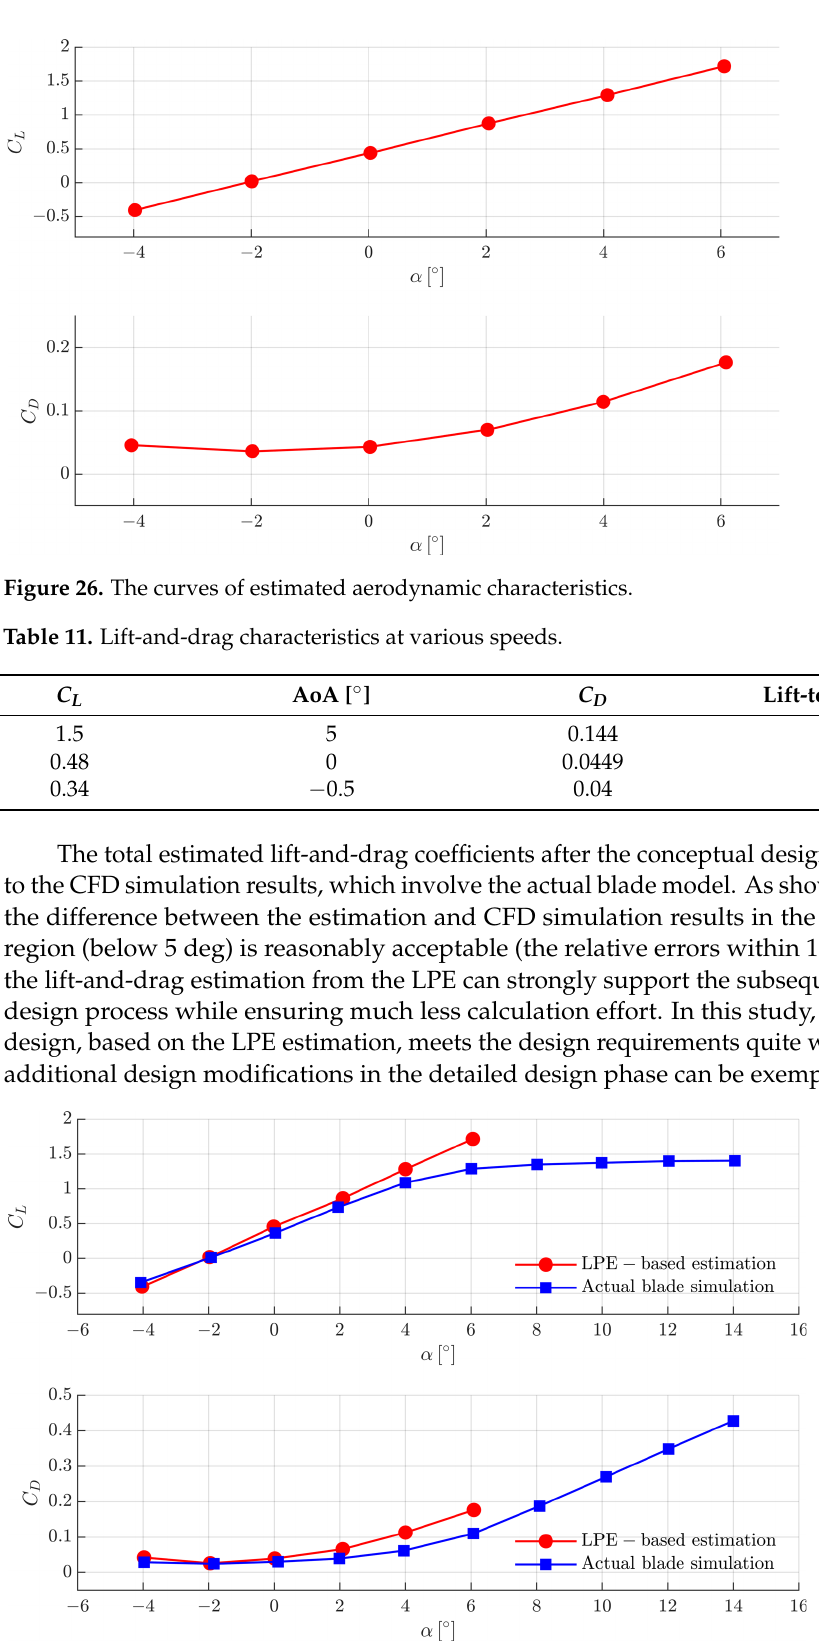
Figure 27. The total lift-and-drag coefficients from the LPE-based estimation and the CFD simulation involving the actual blade model. ( Upper ) Lift coefficient comparison; ( Lower ) Drag coefficient comparison.